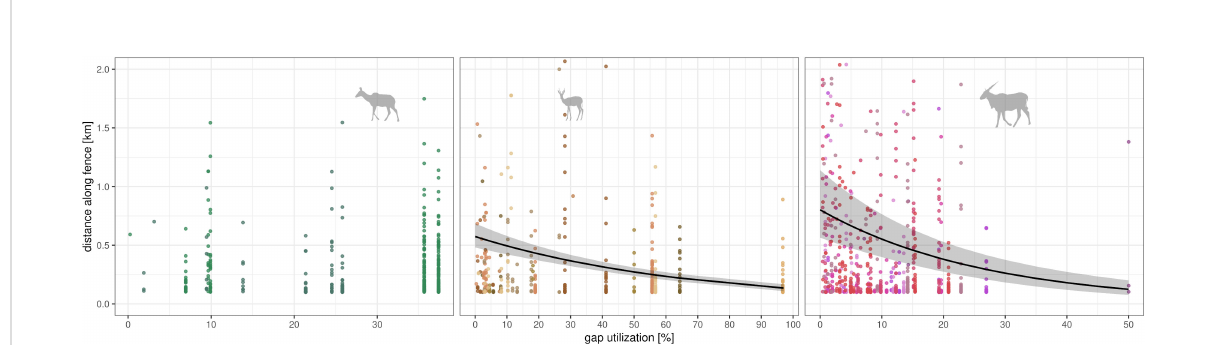
FIGURE 8 Relation between distance moved along fence line and gap utilization. Gap utilization ( x -axis, limited to data) as individual proportion a single gap was used in comparison to the use of all gaps. Single points show distances along fence of each crossing event ( y -axis). Species-wise (in panels, see symbol) prediction from GLMM (black lines, Gamma distribution with logarithmic link function) with con fi dence intervals (gray areas) for fi xed effect.